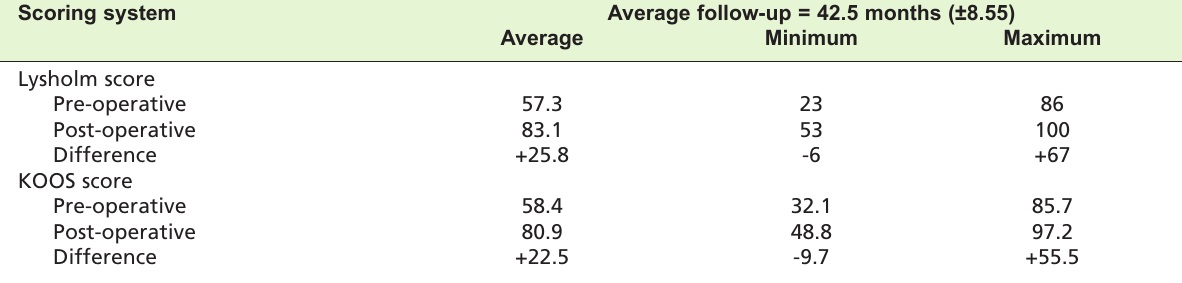
Table II: Patient-reported